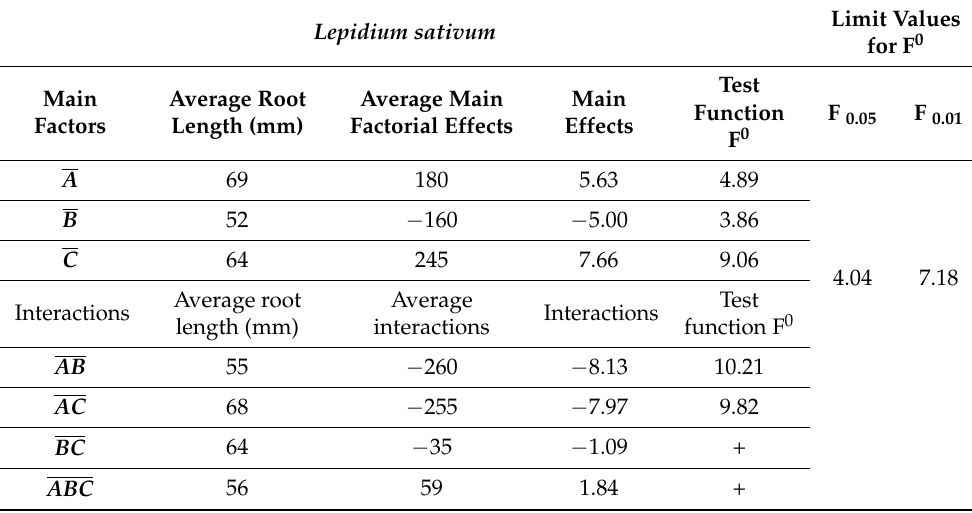
Table 10. Mean main factorial effects, average interactions, and their significance for Lepidium sativum